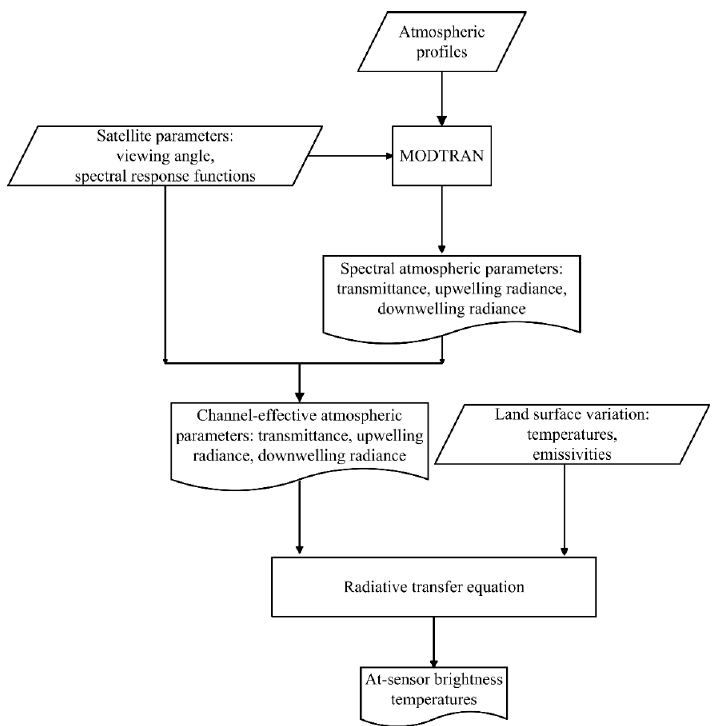
Figure 4. The procedure for generating the simulation data.